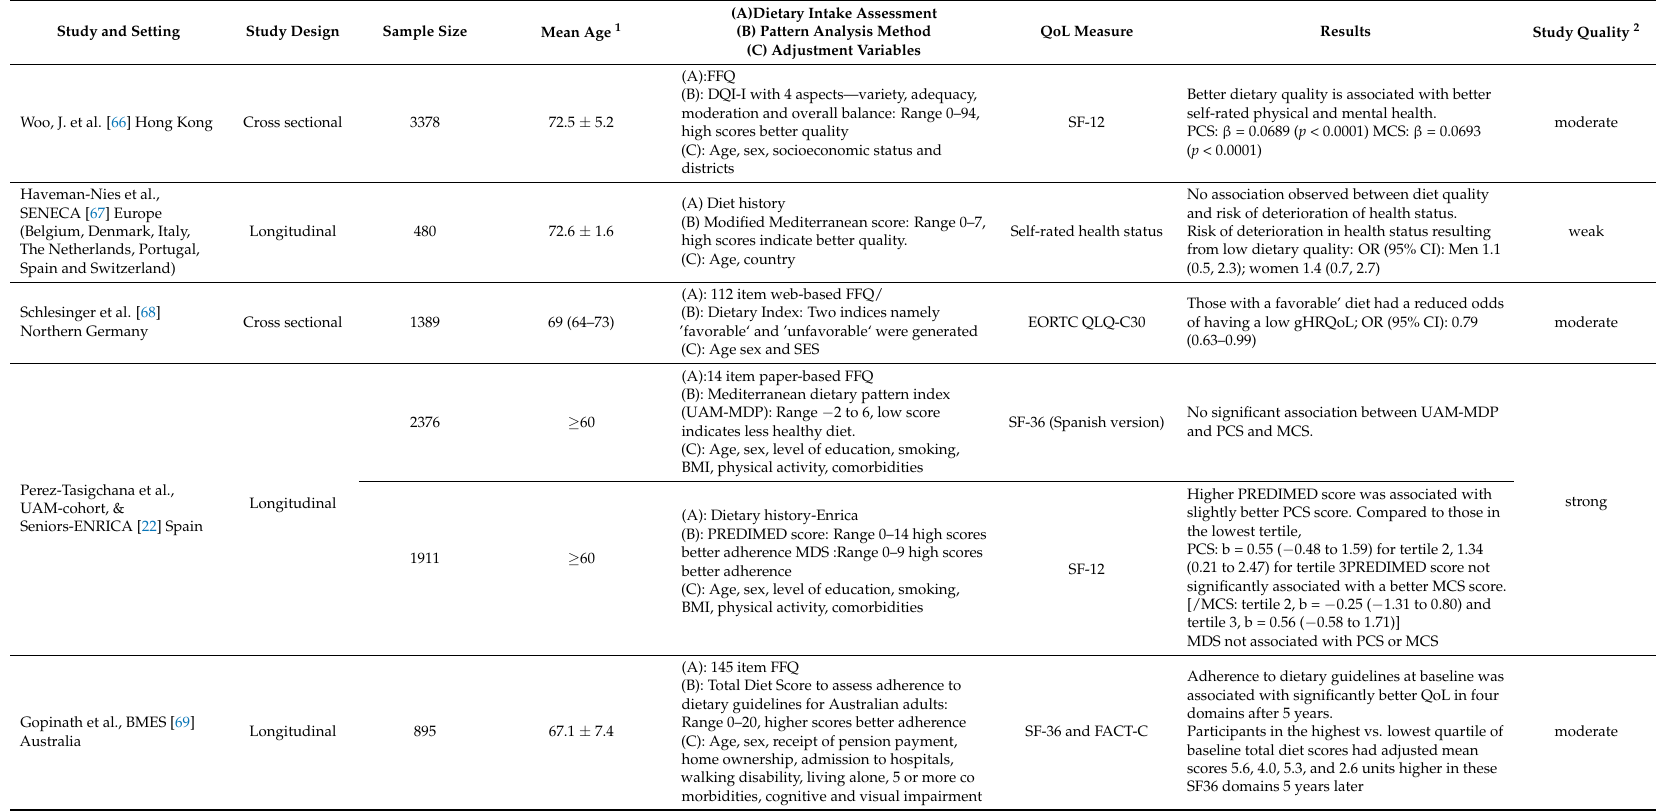
Table 1. Characteristics of the studies included in the systematic review.